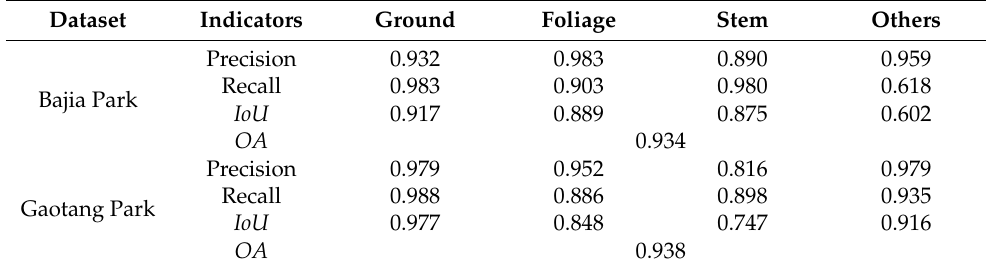
Table 2. The Recall, Precision, Overall Accuracy, and IoU .